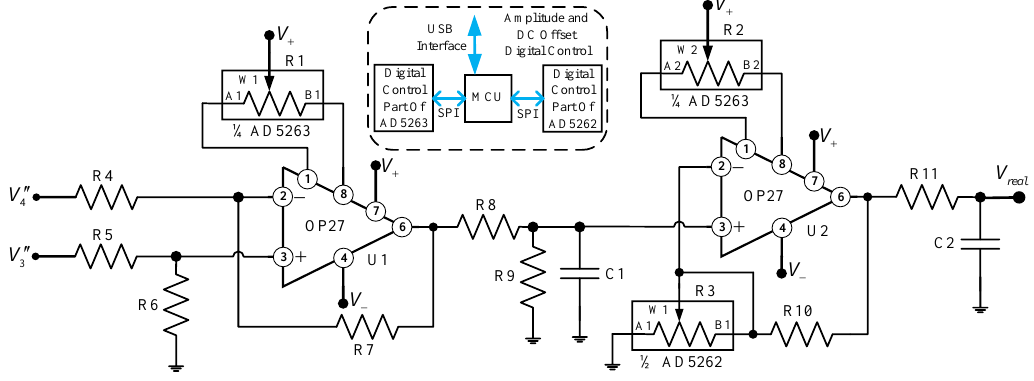
Figure 2. The schematic of the digital programmable low frequency amplification circuit of the in-phase correlating subunit.